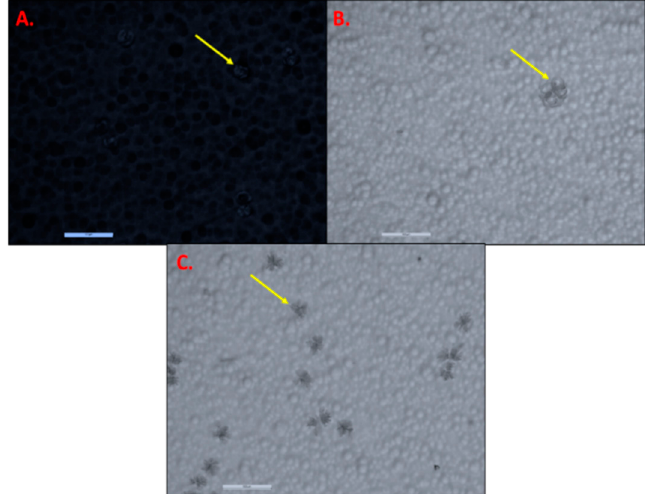
Figure 2. TAF crystals in acrylate based transdermal patches (at 10 × ). ( A ) Patch AP5 (crystals at 40 ◦ C after 2 weeks). ( B ) Patch AP9 (crystals at RT in 12 days). ( C ) Patch AP8 (crystals at RT in first week). Arrows depict TAF crystals